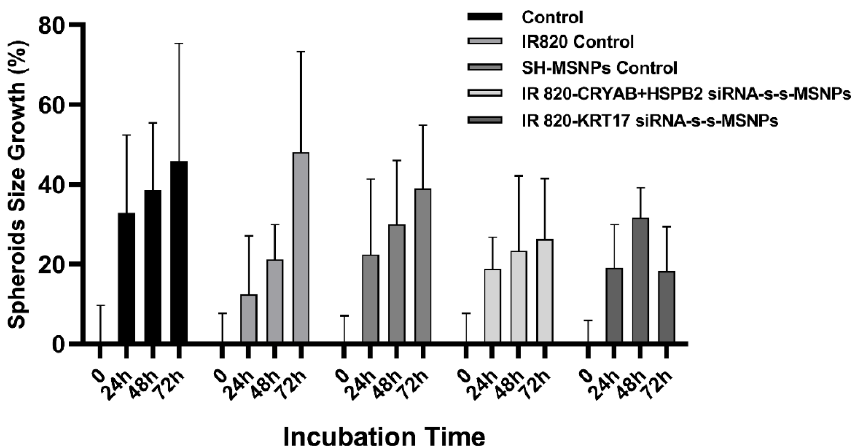
Figure 7. Measurement of IR820 loaded siRNA linked MSNPs effects on cell proliferation. Average spheroid growth in diameter results comparing the relative cell survival rate of RH30 sarcoma cells after treatment with PBS, unbound IR820, SH-MSNPs, IR820-MSNPs linked with CRYAB and HSPB2-targetted siRNA, or IR820-MSNPs linked with KRT17-targetted siRNA, for different periods of time, ranging from 0—72 h ( n = 6). The relative growth percentage was calculated by comparison between the size of the spheroids in each group before and after the treatment for 0–72 h. Data are presented as mean ± SD for each individual cell line.